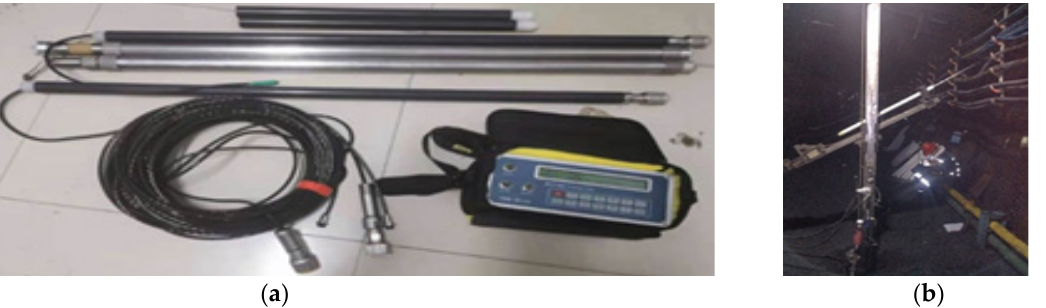
Figure 11. Electromagnetic wave CT detection; ( a ) Electromagnetic wave CT detection equipment; ( b ) Field Construction of electromagnetic wave CT detection.